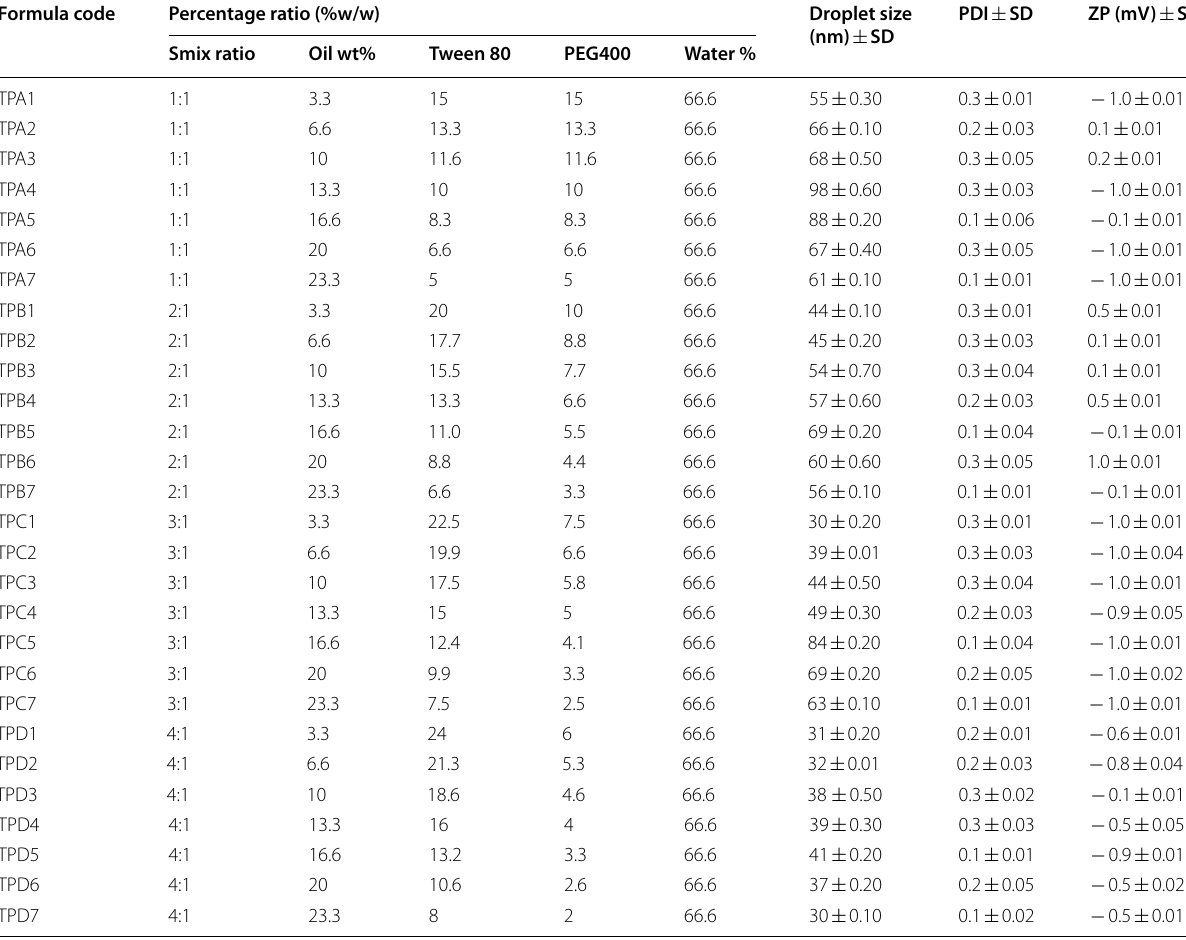
Table 1 Composition and physicochemical properties of different MEL‑loaded ME Formula code